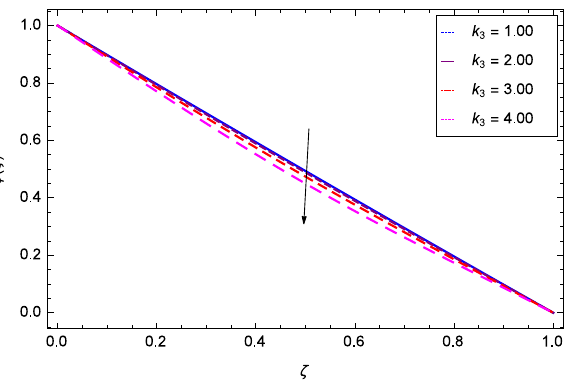
Figure 24. Analysis through stretching parameter k 3 at upper disk and nanoparticles concentration ϕ ( ζ ).